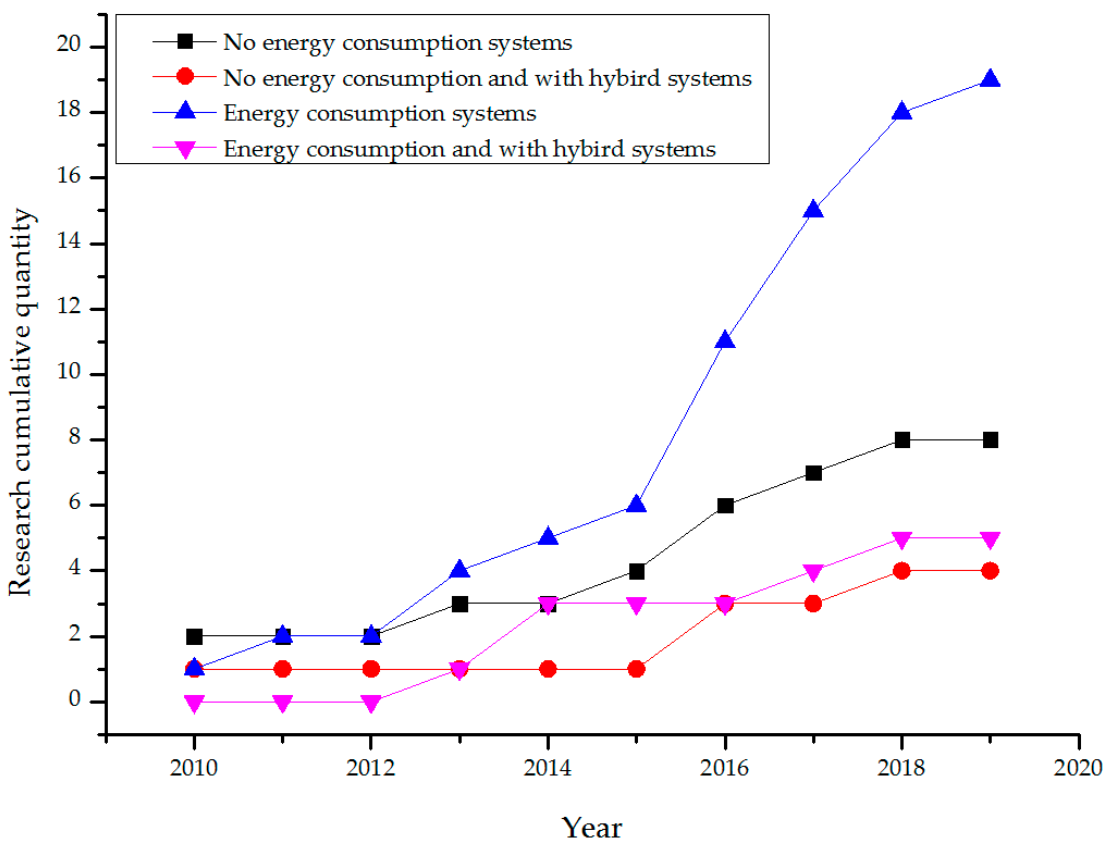
Figure 2. Prototype daylighting systems research literature quantity and trends.